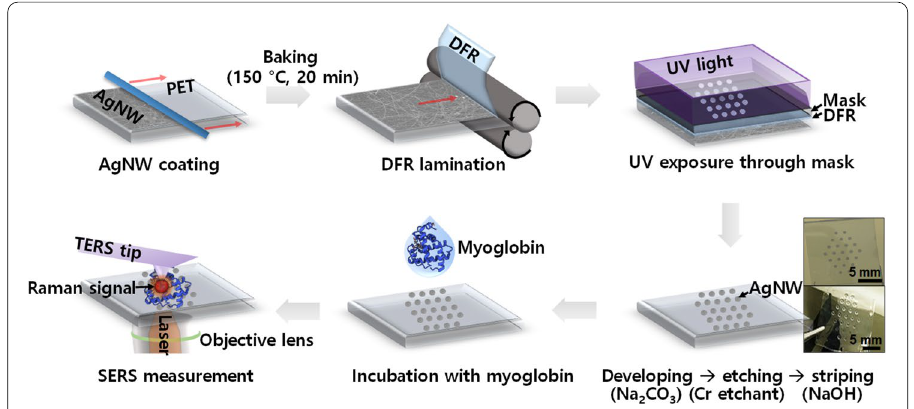
Fig. 1 Schematic of the fabrication and optical detection process of AgNW/PET